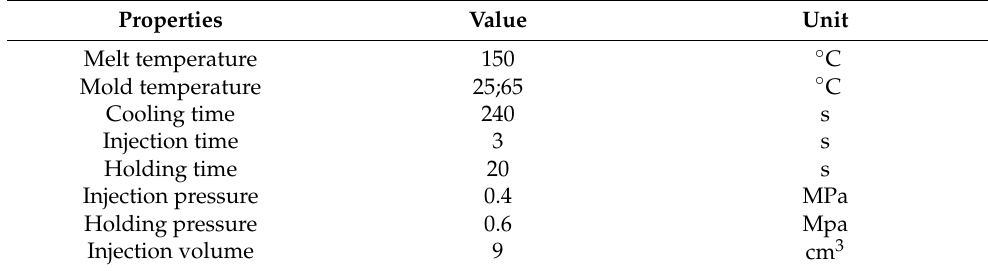
Table 1. Injection molding